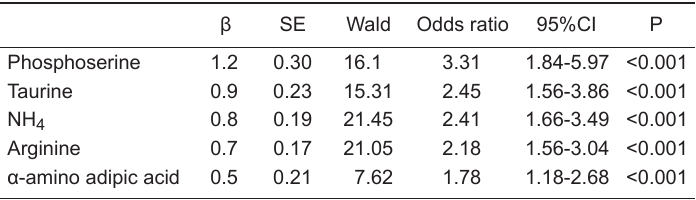
Table 3. Logistic regression model for levels of significant amniotic fluid amino acid